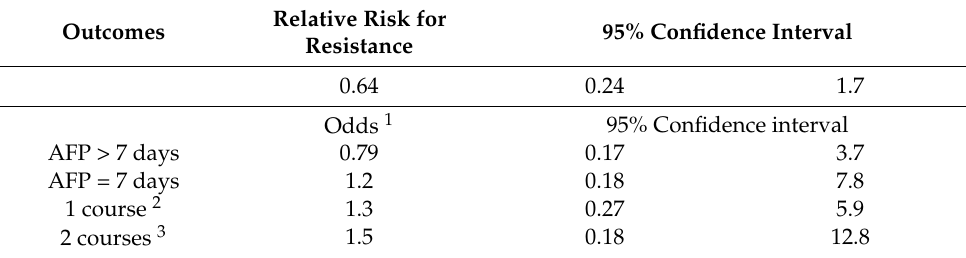
Table 5. Relative risk and odds for resistant cultures in participants with prior antibiotic